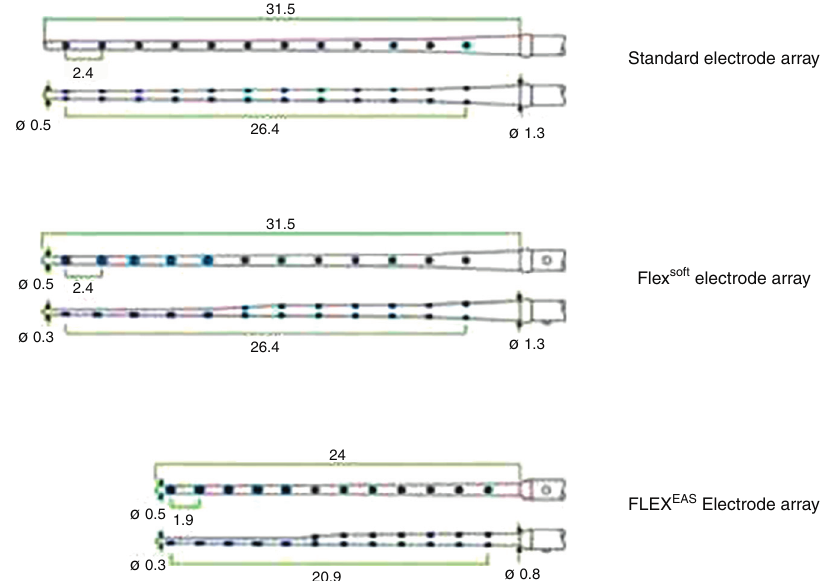
Figure 2 Schematic representation of MED-EL FLEX TM EAS (21 mm) electrode. Standard electrode array.